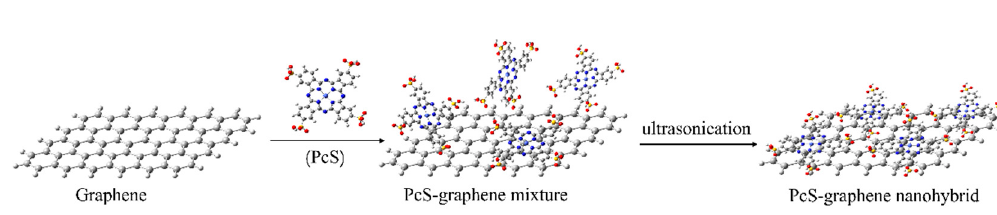
Figure 5. Schematic diagram of the interaction process of PcS and graphene with ultrasonic treatment.